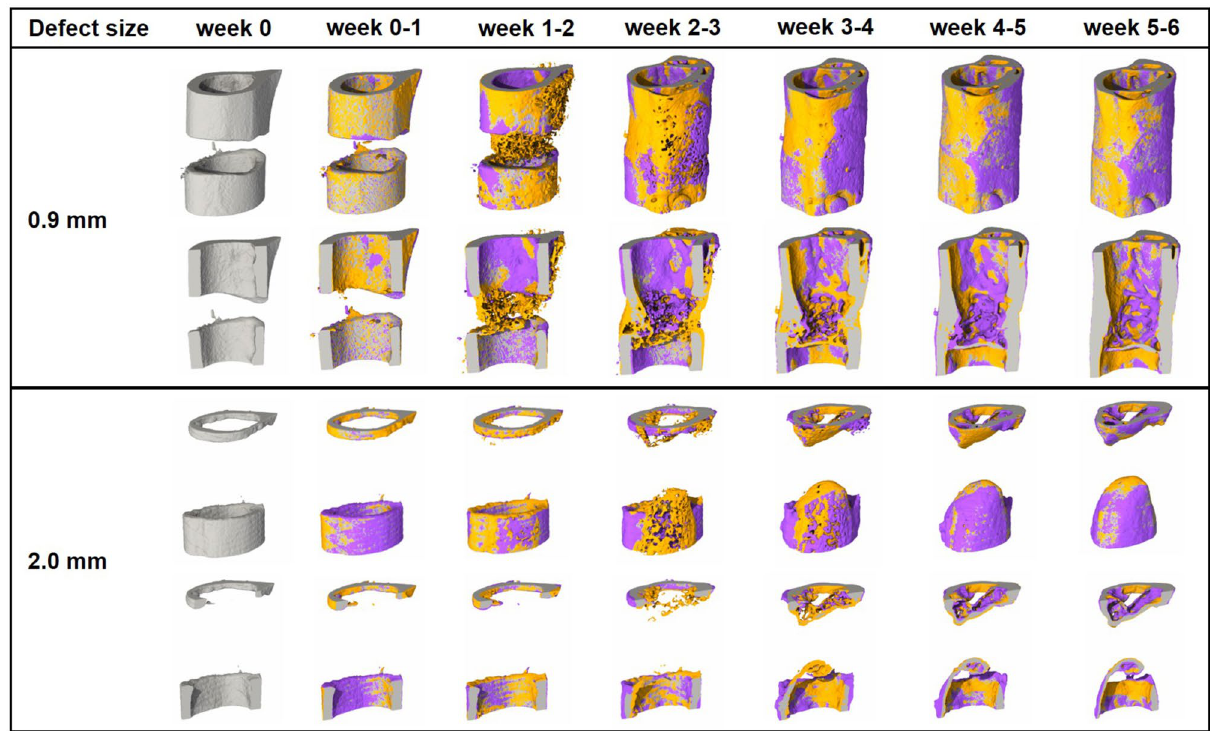
Figure 1. Representative images (threshold: 645 mg HA/cm 3 ) of the defect region from animals of the 0.9 mm group (top) and the 2.0 mm group (bottom). Visualization of bone formation (orange) and resorption (blue) via registration of micro-CT scans from weeks 1–6 to weeks